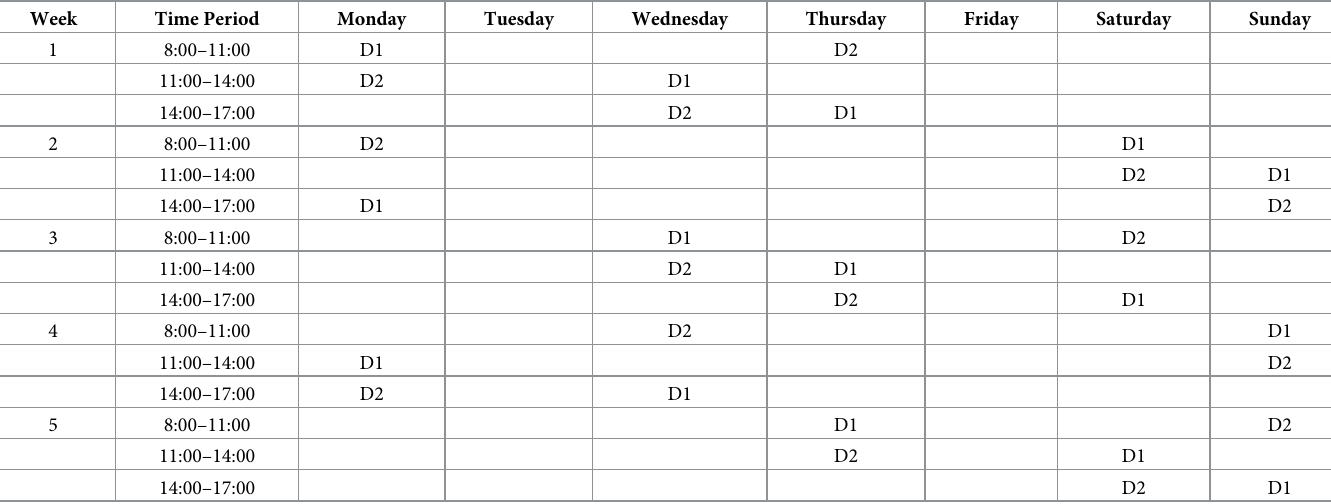
Table 1. Observation schedule used to record focal animals across all